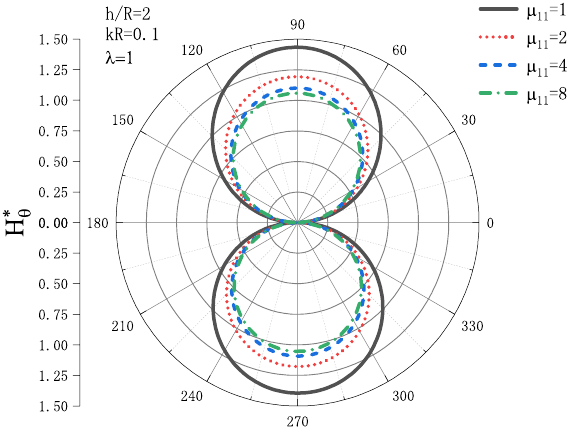
* µ 11 when incident frequency kR = 0.1 θ vs. the ratio of